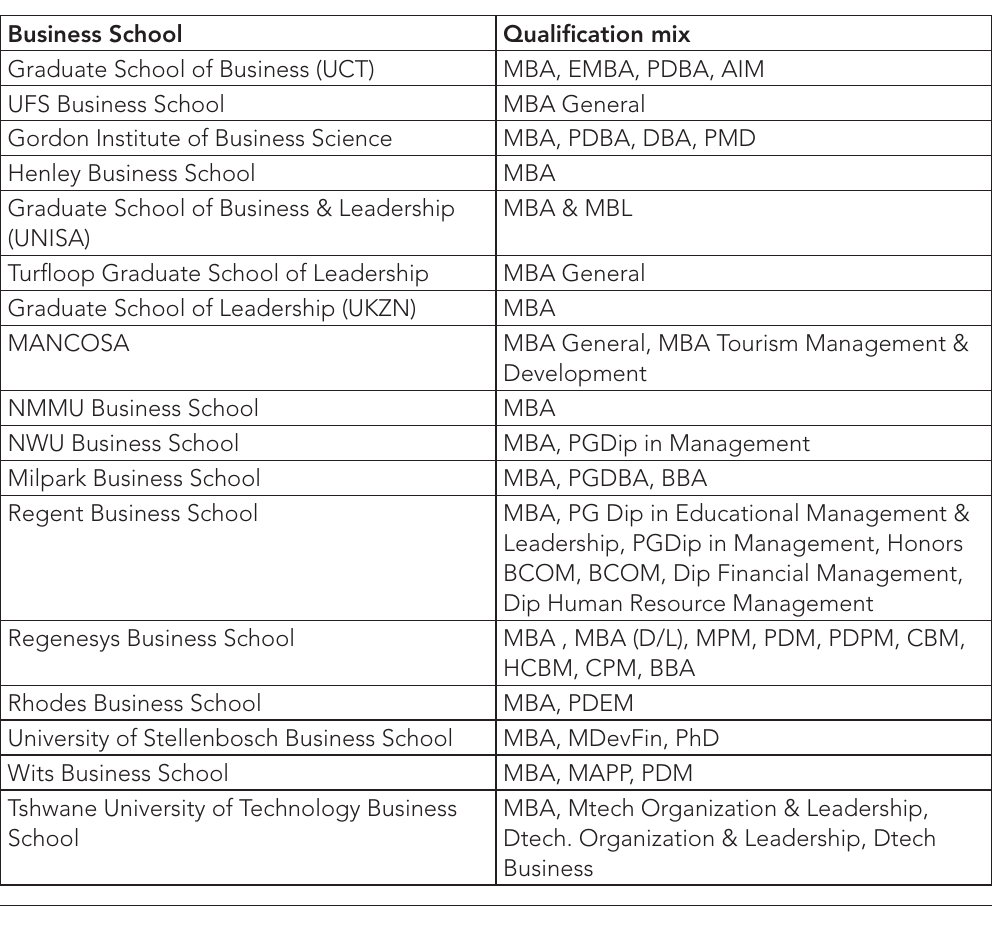
Table 5: Business schools qualification mix